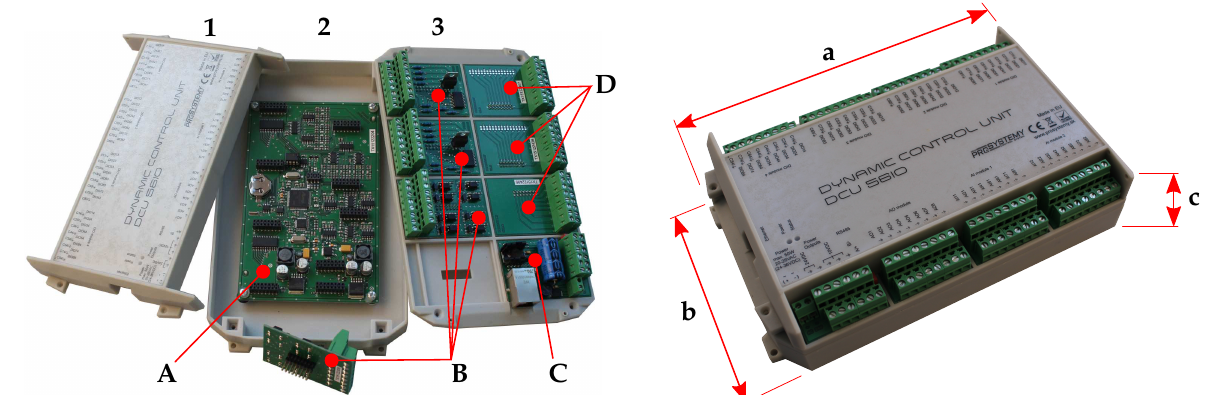
Figure 2. Dynamic control unit—DCU56IO (decomposed on the left). A —main DCU board; B —digital modules; C —power and communication module; D —analog modules; 1 —top cover; 2 —chassis; 3 —mid cover; a —width (230.2 mm); b —heigh (138 mm); and, c —depth (53.5 mm).